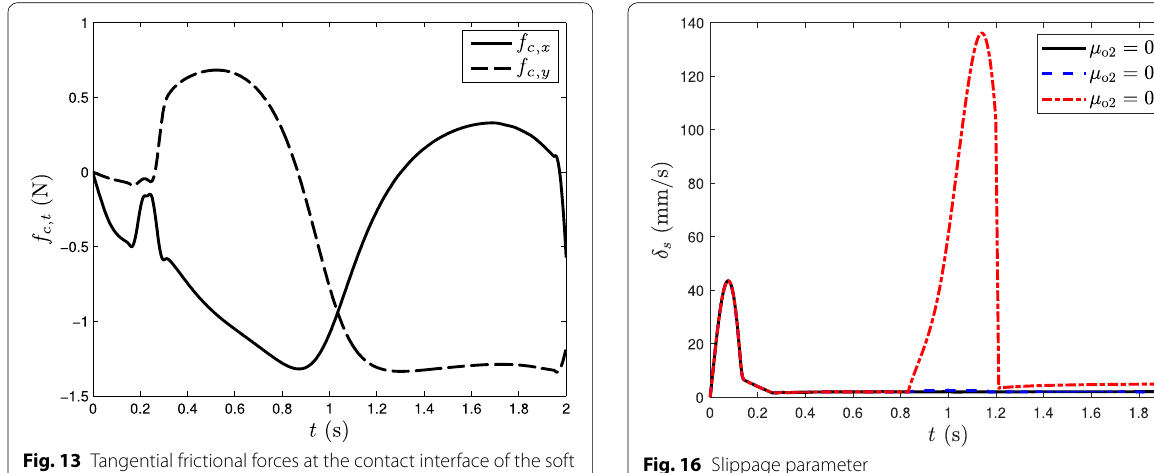
Fig. 16 Slippage parameter